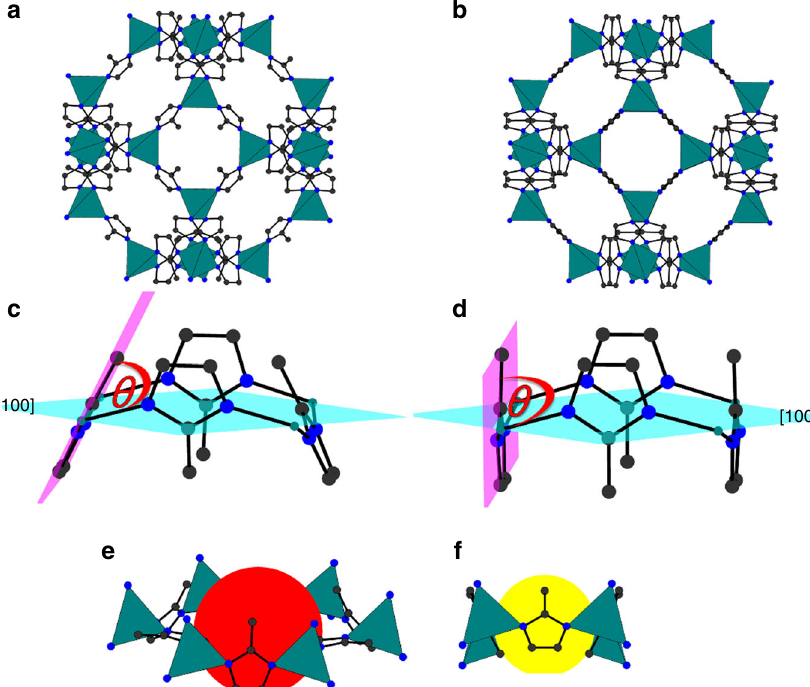
Fig. 1 Structural differences of ZIF-8-AP and ZIF-8-HP. a ZIF-8-AP with 4MR window in the faces and 6MR windows in the body diagonal. b ZIF-8-HP with mIm linkers rotated by 30° compared to the AP structure c 4MR window showing the opening angle of 68° for ZIF-8-AP, d 4MR window showing the opening angle of 89° for ZIF-8-HP, e 6MR window with pore diameter of 3.0 Å and f 4MR window with pore diameter of 0.8